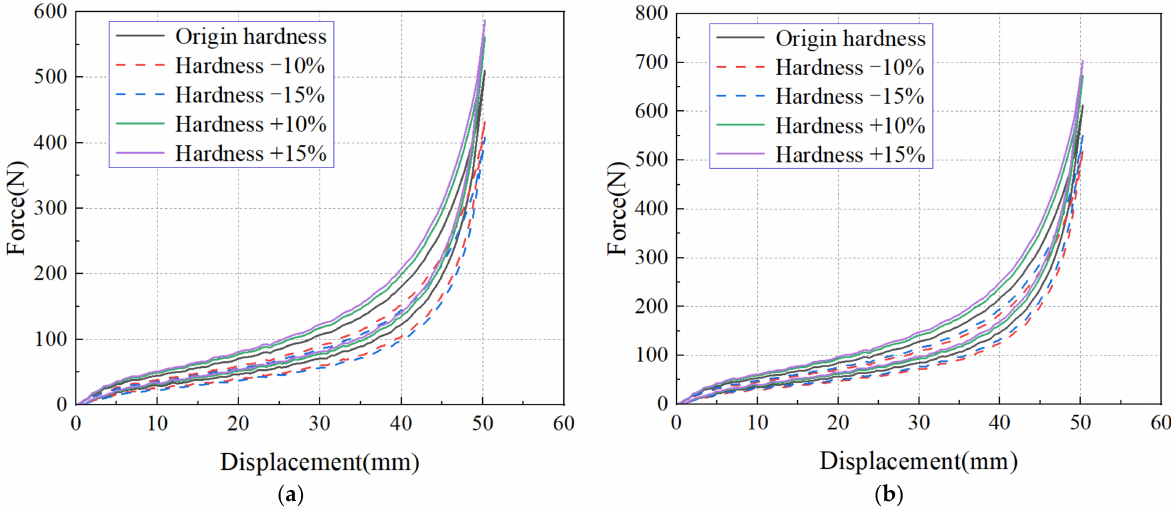
Figure 13. Sponge stiffness characteristic: ( a ) cushion upper layer sponge stiffness; ( b ) cushion lower layer sponge